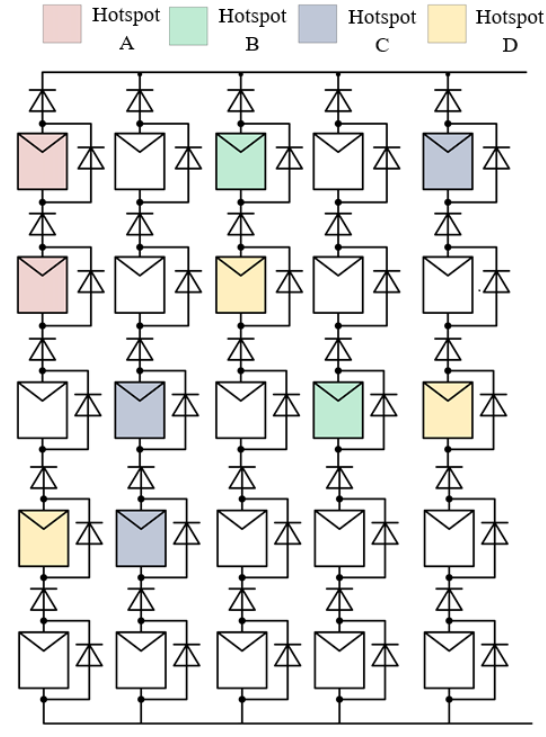
Figure 16. Simulation circuit diagram for hotspot